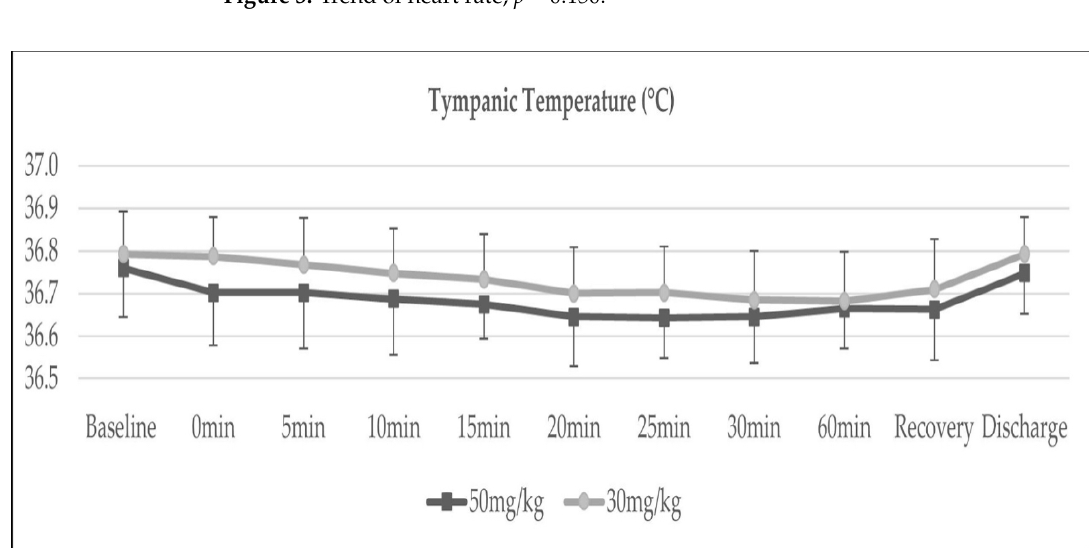
Figure 4. Trend of core temperature, p = 0.634.